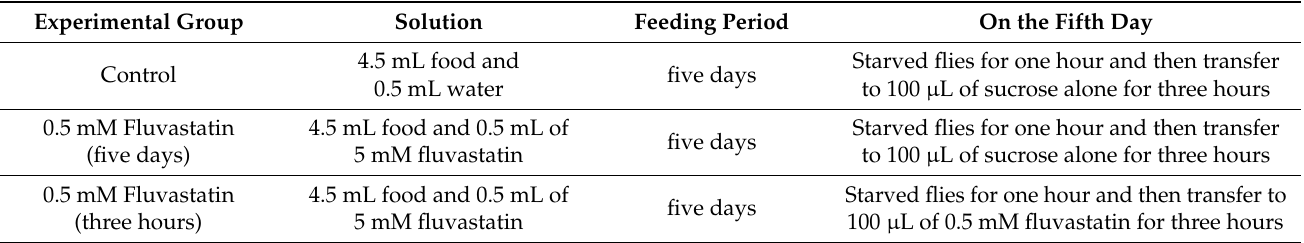
Table 2. Acute and chronic feeding pattern for fluvastatin groups and control group.